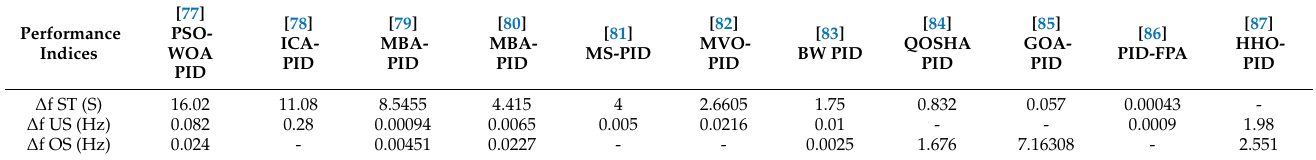
Table 2. Performance Indices of PID Controller in an Isolated Power